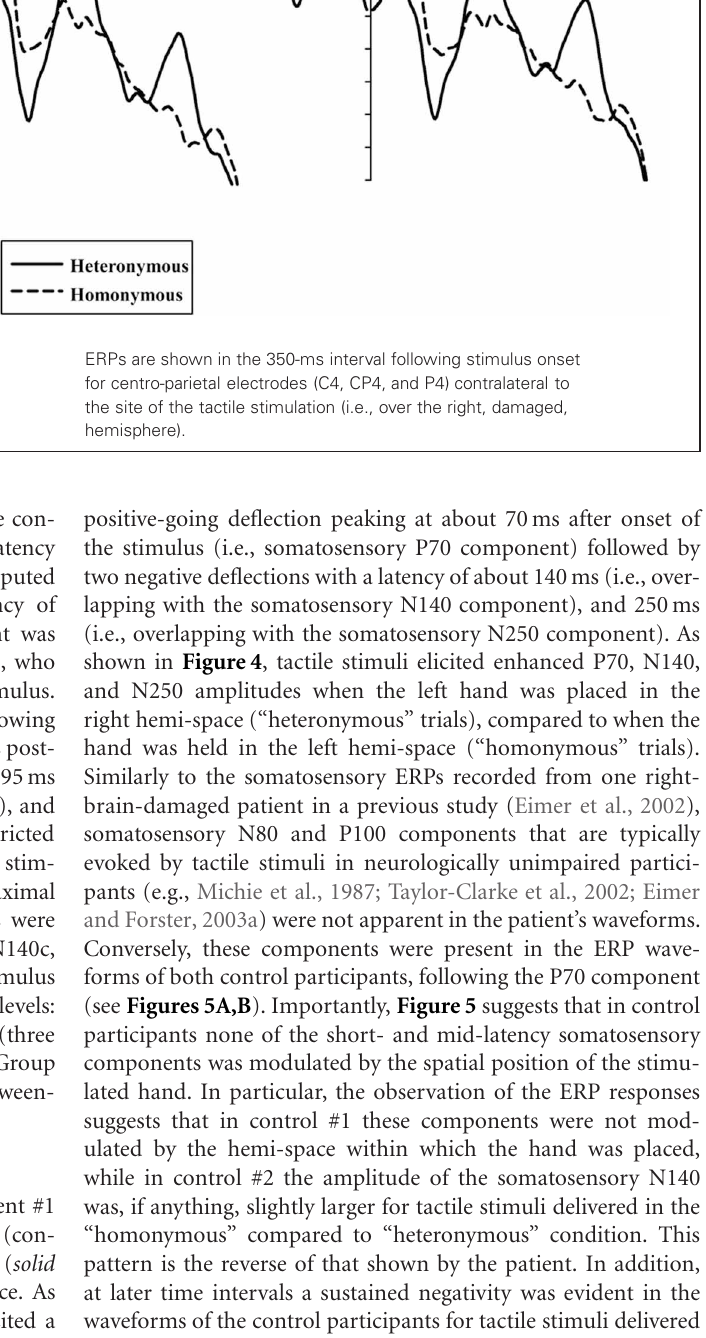
ERPs are shown in the 350-ms interval following stimulus onset for centro-parietal electrodes (C4, CP4, and P4) contralateral to the site of the tactile stimulation (i.e., over the right, damaged,